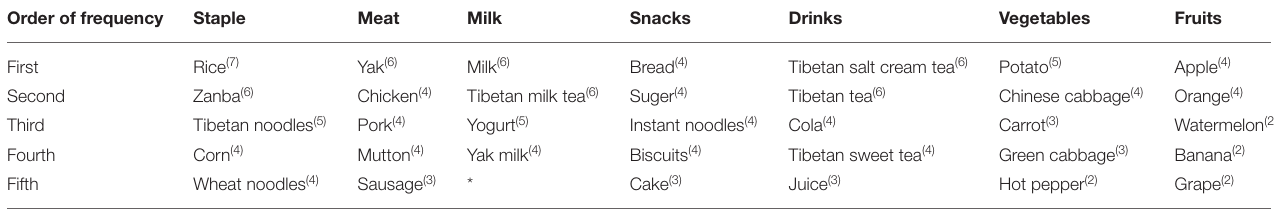
TABLE 2 | The five most frequently consumed foods from the seven food groups. Order of frequency Drinks Vegetables Fruits